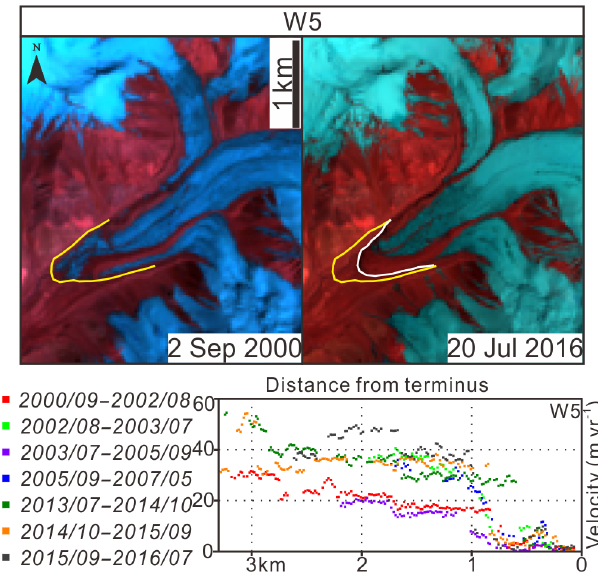
Figure 9. Comparison of W5 between 2000 and 2016 and its centre line annual-velocity profiles. The yellow line indicates its terminus position in 2000 and the white line indicates its terminus position in 2016.